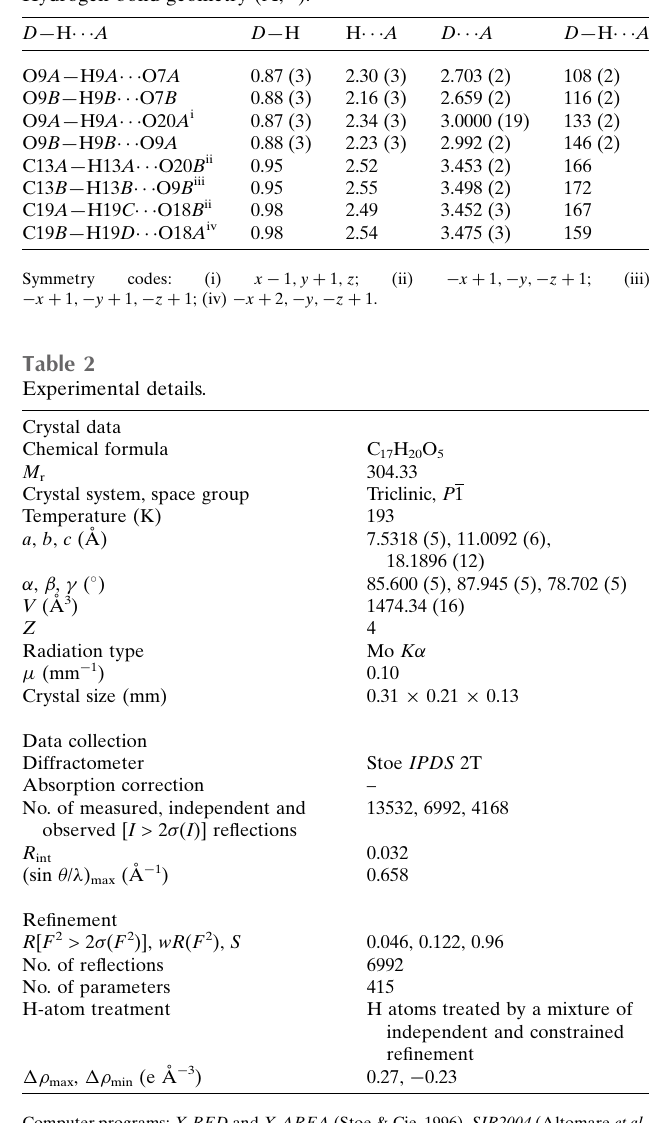
Table 1 Hydrogen-bond geometry (A˚ , (cid:2) ).